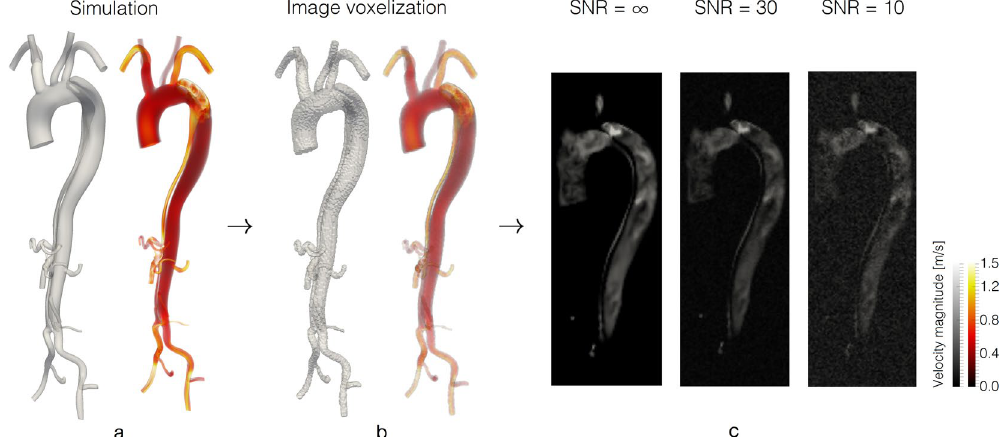
Figure 2. Generation of in-silico image data from patient-specific flow simulations. (a) Patient-specific simulation of an acute type B dissected aorta (left) with corresponding mid-systolic ( t = 0.17 s) velocity magnitude (right). (b) Simulated patient-specific geometry resampled onto a uniform image voxel grid of 2 mm 3 (left) together with the corresponding flow field (right). (c) Coronal cut through the aortic arch in the in-silico image data without noise (SNR = ∞ , left), with low-noise (SNR = 30, middle), and with high-noise (SNR = 10,